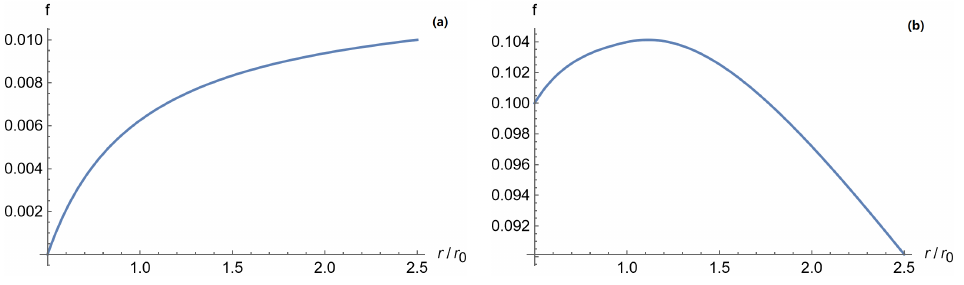
Figure 1. Numerically constructed solutions with different initial data: ( a ) f = 0, f (cid:48) = 0.025, f (cid:48)(cid:48) = − 0.1; ( b ) f = 0.1, f (cid:48) = 0.02, f (cid:48)(cid:48) = −